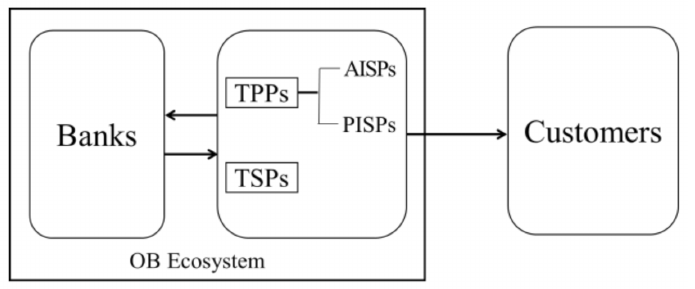
Figure 1. Open banking (OB)